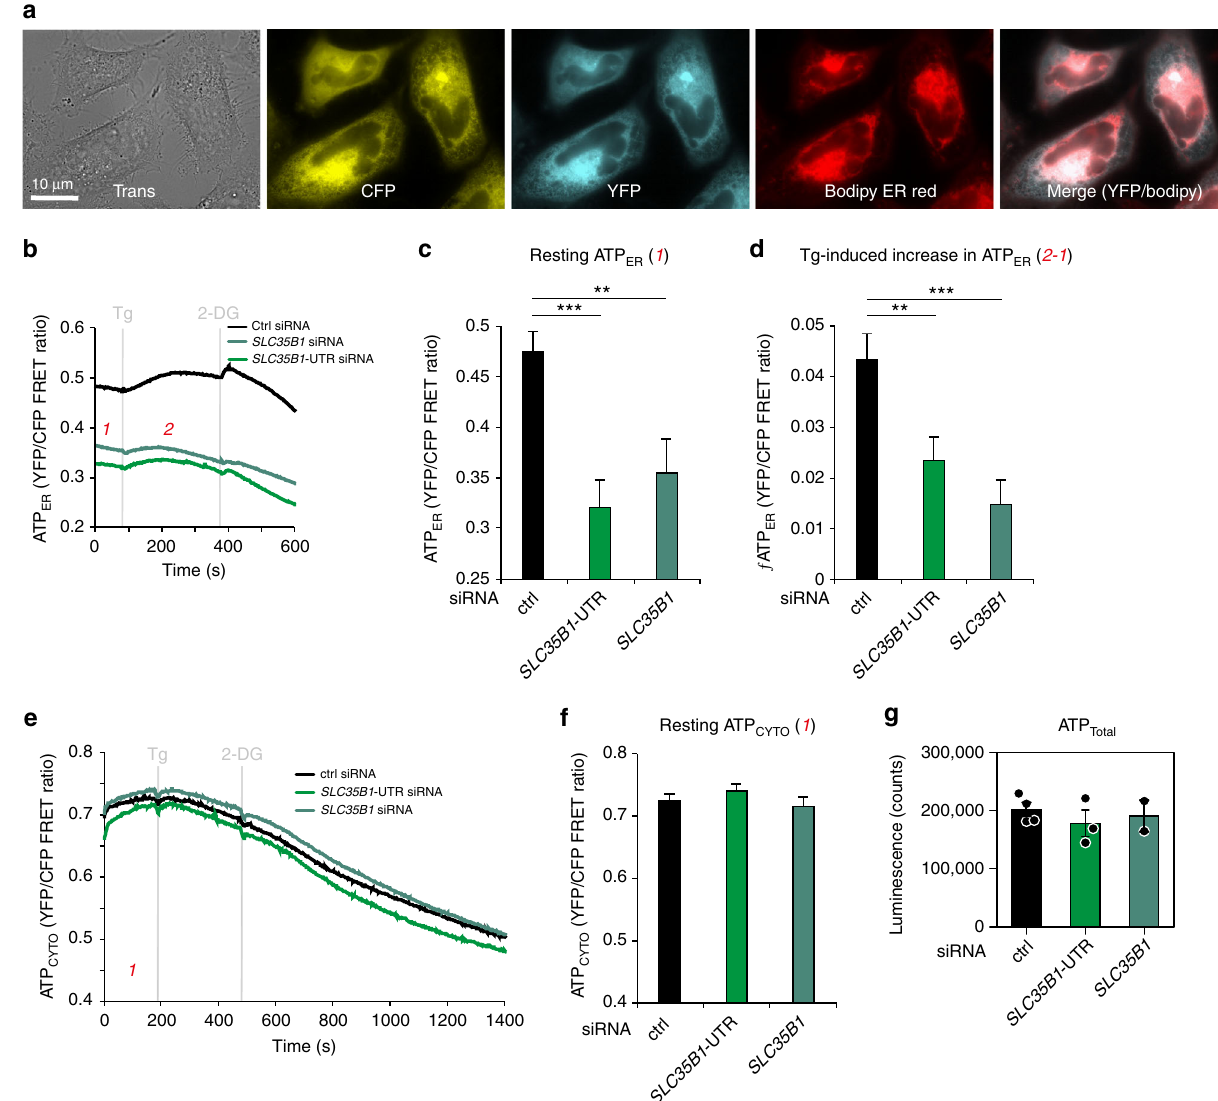
Fig. 6 ERAT4.01 reveals ATP depletion in the ER of HeLa cells after SLC35B1 knockdown. a – d HeLa cells were transfected with control siRNA or with SLC35B1 - or SLC35B1 -UTR-targeting siRNA for 72 h, then transfected with ERAT4.01. After 24 h, they were imaged by fl uorescence microscopy. Where indicated, Thapsigargin (Tg, 1 µ M) or 2-deoxy-glucose (2-DG, 10 mM) were added. a Images were recorded using transmission light or fl